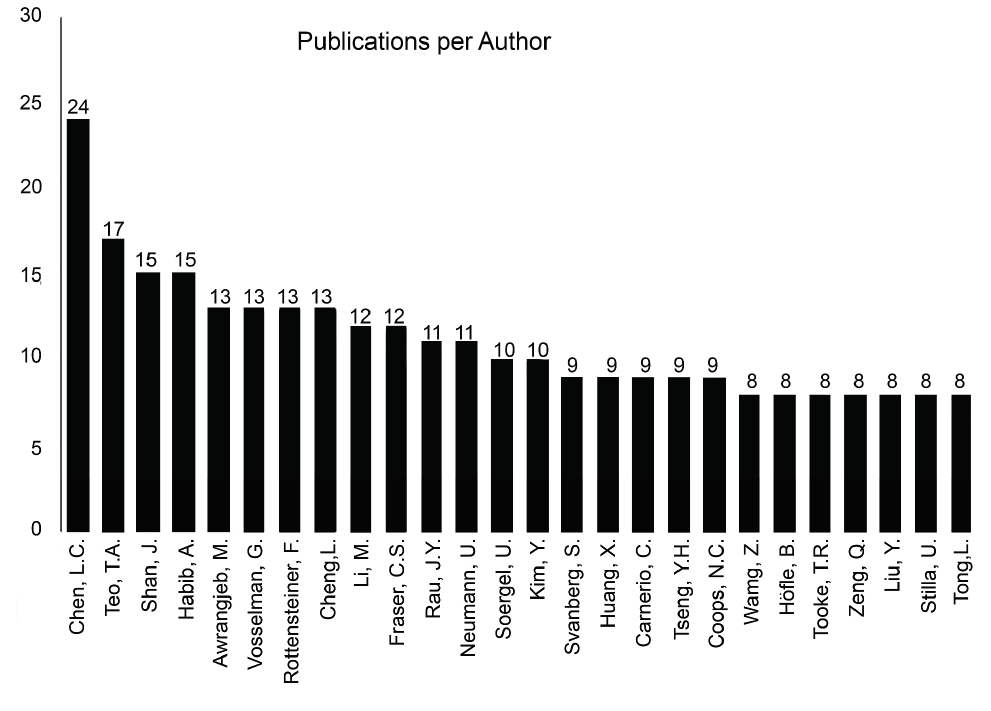
Figure 4. Number of topic related publications per author for period from 1998 to 2014